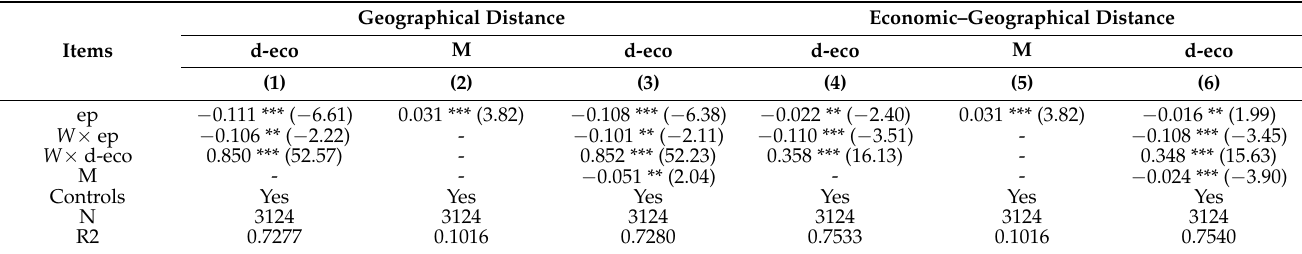
Table 10. Mechanism test of policy tightening